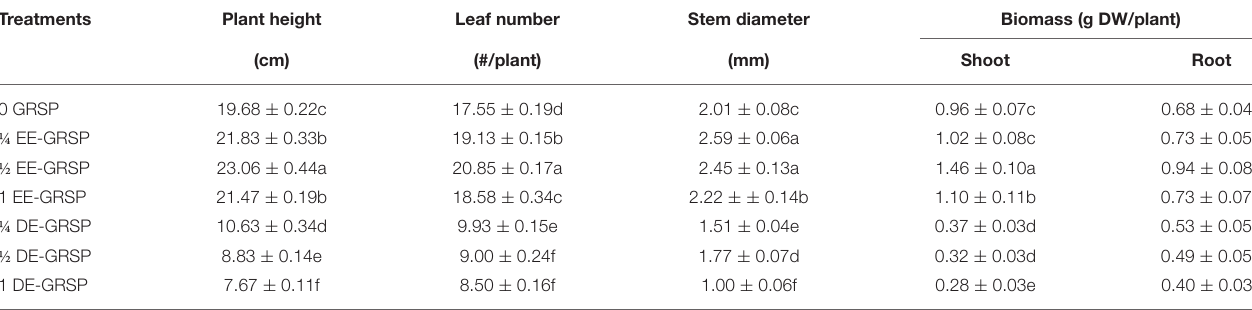
TABLE 2 | Effects of exogenous GRSP on plant growth performance of potted trifoliate orange seedlings. Treatments